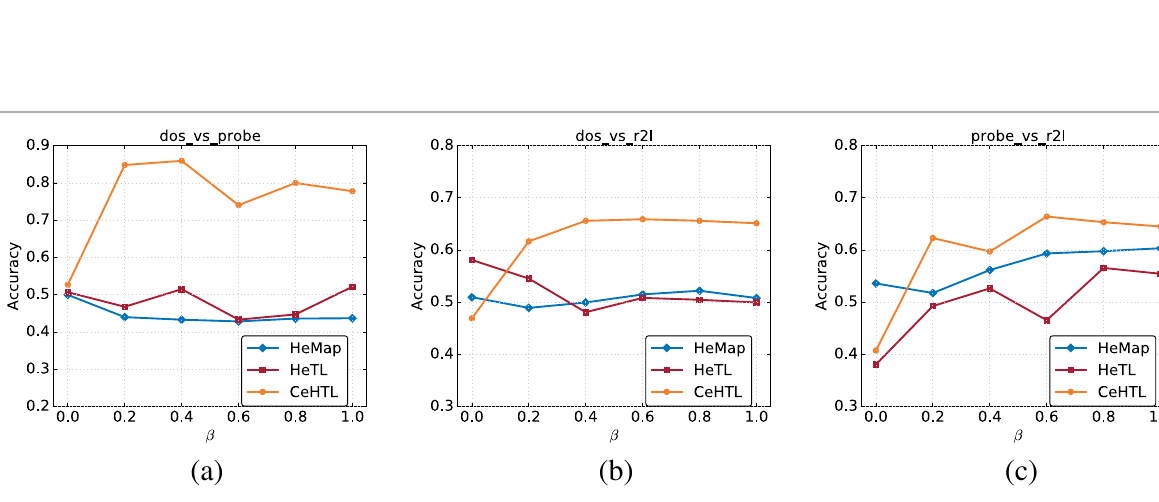
Fig. 10 Study of parameter β sensitivity on three main detection tasks, sample = 1000. a DoS → Probe. b DoS → R2L. c Probe → R2L